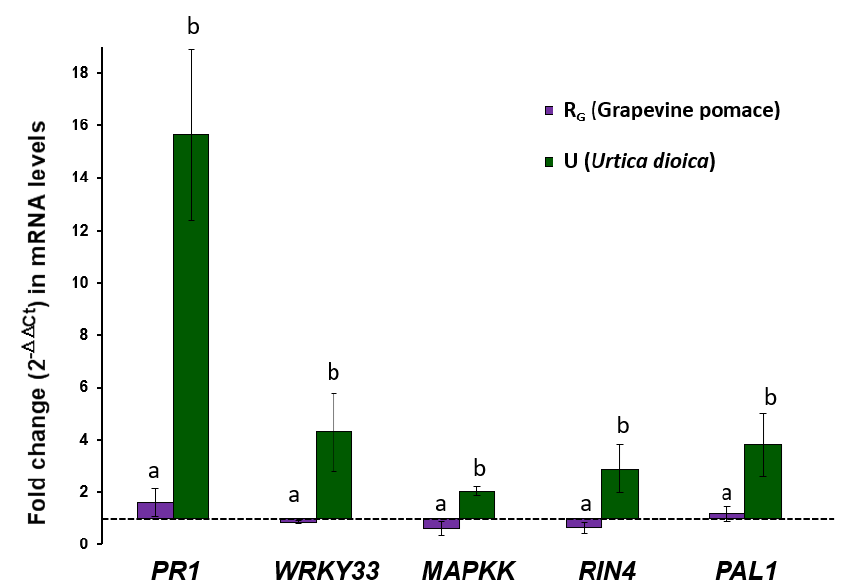
Figure 5. Analysis of relative expression levels with respect to Mock (dash line) of common bean defense-related genes ( PR1 , WRKY33 , MAPKK , RIN4 , and PAL1 ) after grapevine pomace (R G , purple bars) and nettle (U, green bars) application. Data shown are the mean ± SE of three independent experiments. Statistically significant differences were analyzed by means of one-way ANOVA with a Tukey post hoc test ( p < 0.05).